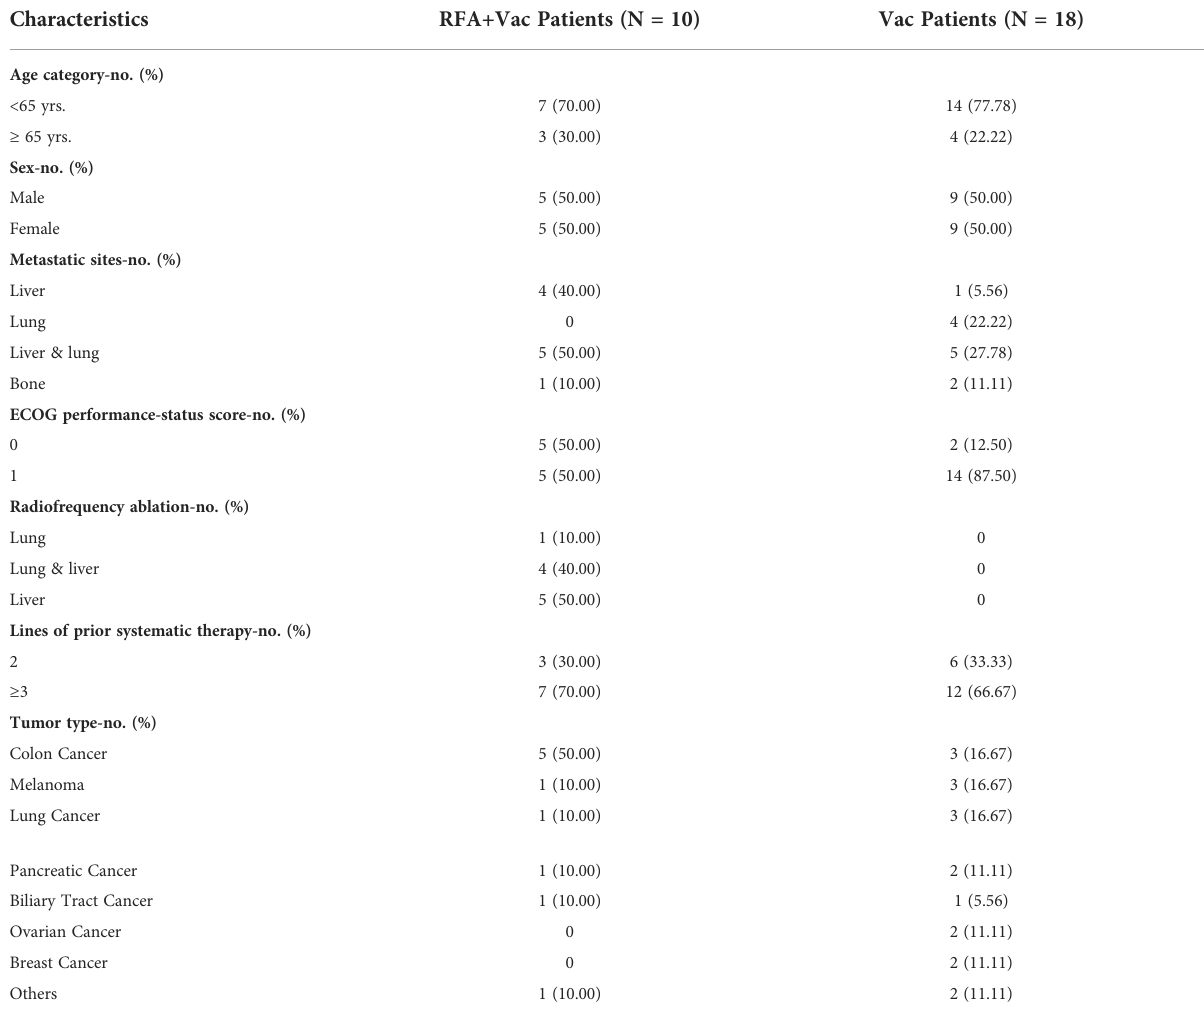
TABLE 1 Demographics and characteristics at